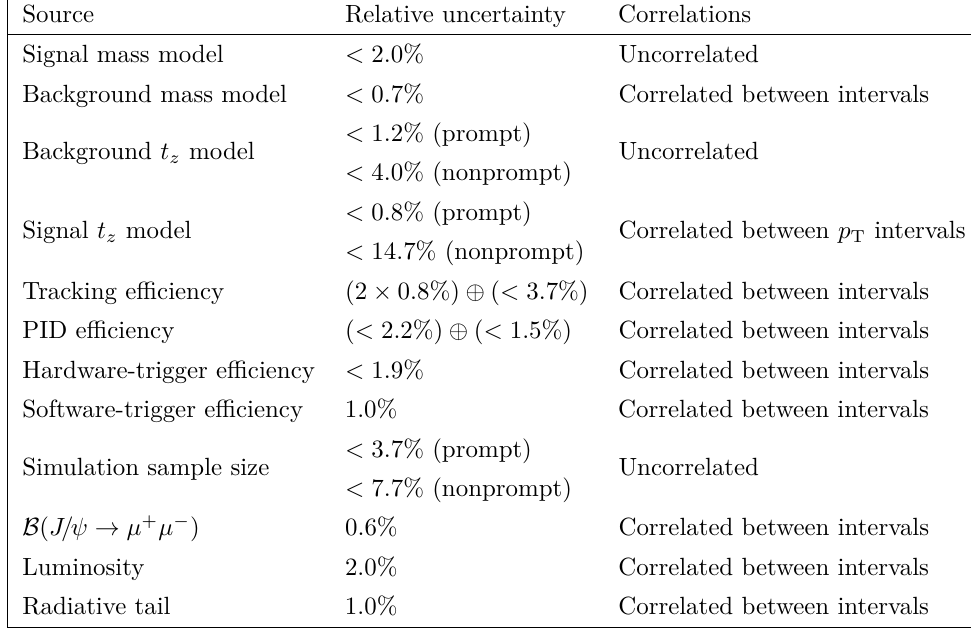
Table 1 . Relative systematic uncertainties on the measurement of the J/ψ production cross-section. The symbol ⊕ means addition in quadrature. The detailed uncertainties for each ( p T , y ) interval are in appendix